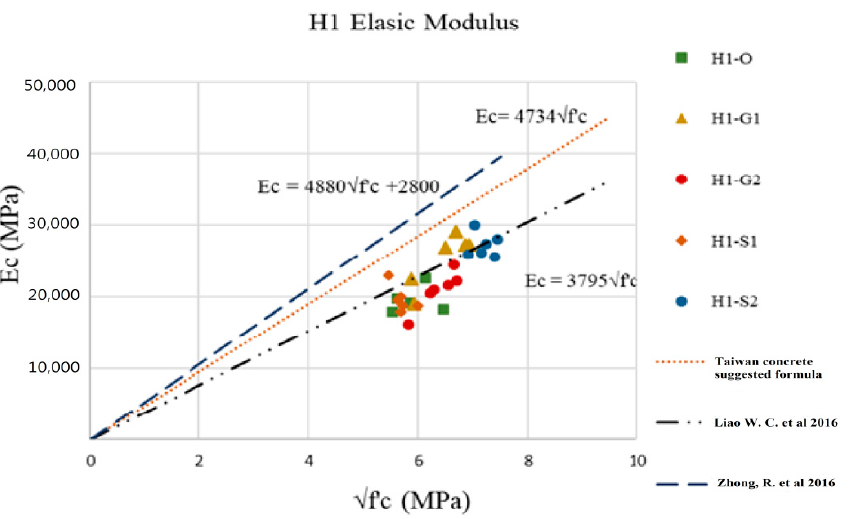
Figure 9. Elastic modulus distribution diagram for H1.2 high-strength pervious concrete speci- mens. 3.4. Flexural Strength Test